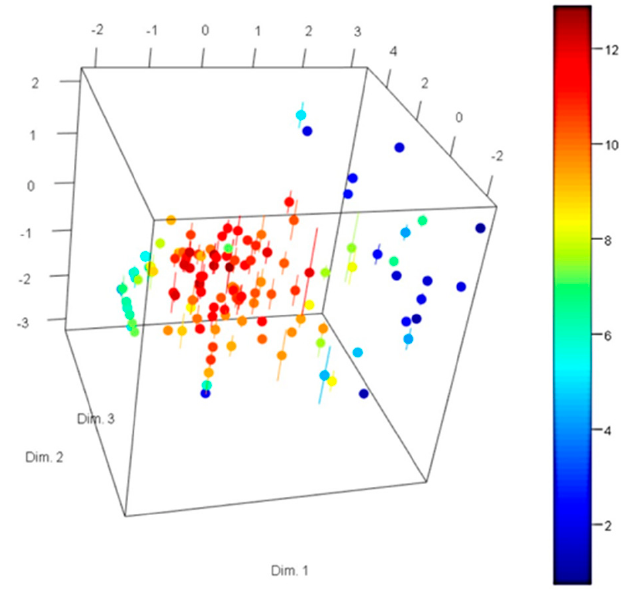
Figure 3. Three-dimensional visualization of Fievet et al. [43] enzyme balances after PCA (Dim1: 43.55%, Dim2: 23.78% and Dim 3: 17.56%). The change from blue to red indicates the gradient from low to high fluxes, respectively. Standard deviation of experimental flux is represented on the